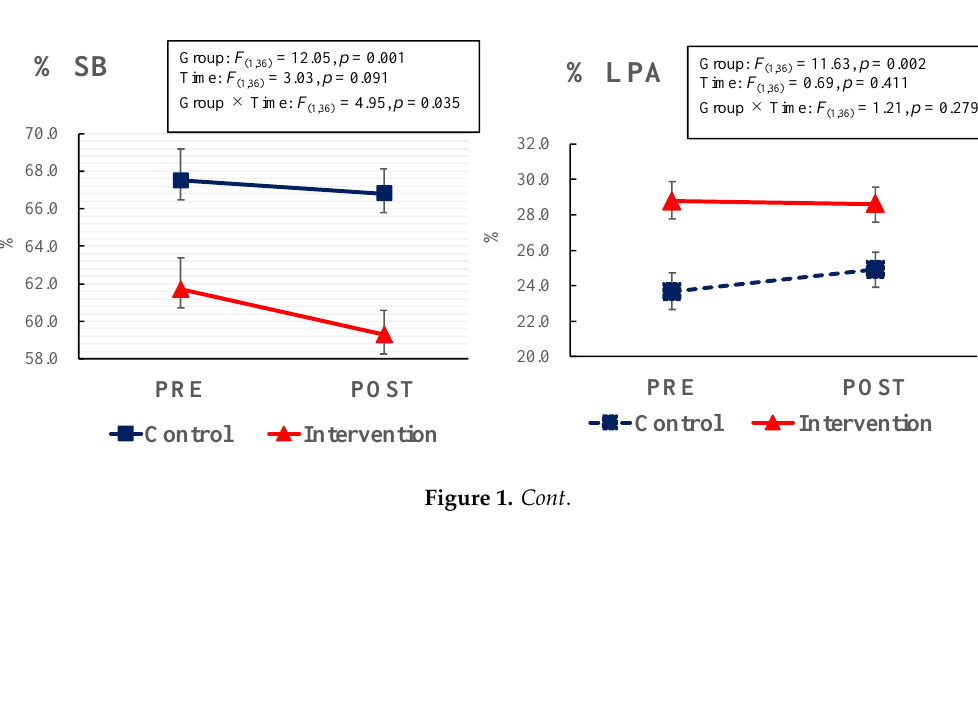
Figure 1. Changes in physical activity and sedentary behavior between intervention and control classes. Data are presented as percentages and standard error. Two-way ANOVA (group × time) was performed to examine the changes in activity levels between baseline and follow-up in the two classes. If the interaction was significant, post-hoc analysis was performed to examine the simple main effects in each